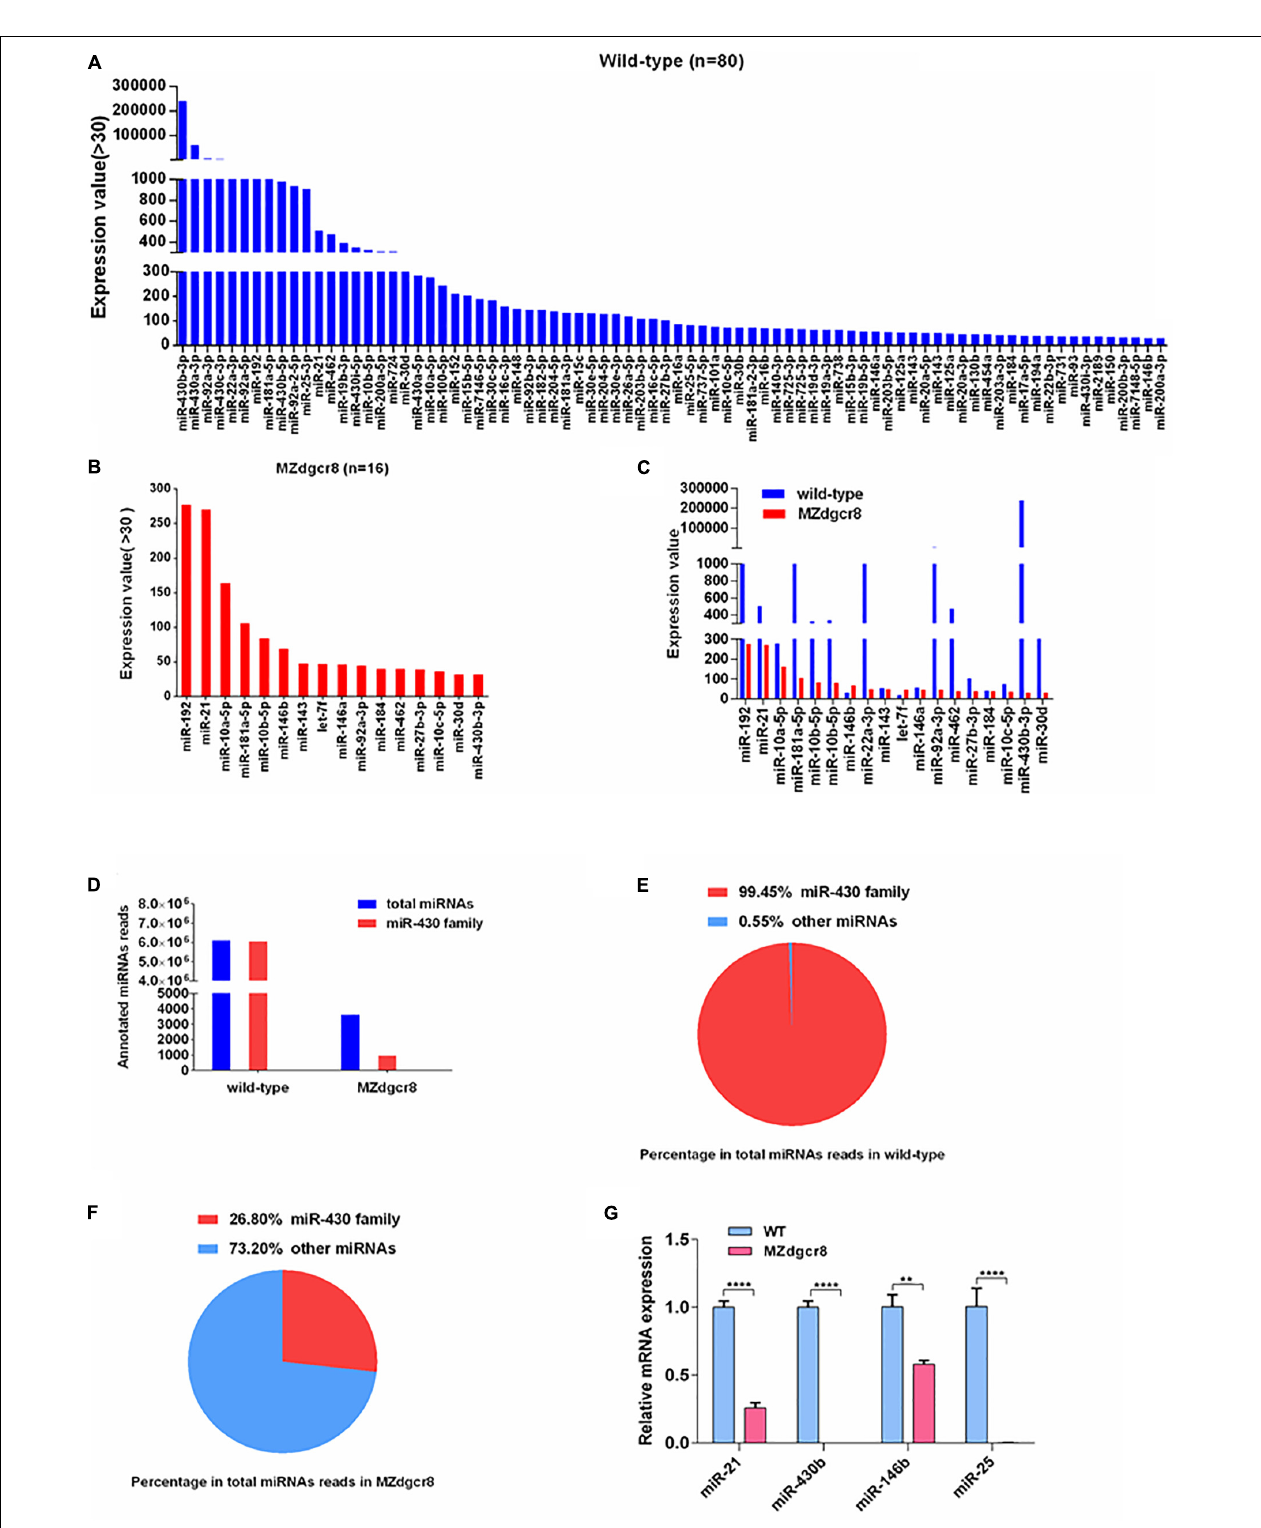
FIGURE 6 | Expression value of miRNAs in wild-type and MZ dgcr8 embryos and qPCR validations. (A) 80 miRNAs for values greater than 30 were obtained in wild-type embryos. (B) 16 miRNAs for values greater than 30 were obtained in MZ dgcr8 embryos. (C) miRNAs with higher values in wild-type and MZ dgcr8 . (D) Total miRNAs read count and miR-430 family read count in wild-type and MZ dgcr8 . (E) Percentage of miR-430 family in total miRNAs read count in wild-type. (F) Percentage of miR-430 family in total miRNAs read count in MZ dgcr8 . (G) Validation of some mature miRNAs by real-time PCR. ** p < 0.01 and **** p < 0.0001.